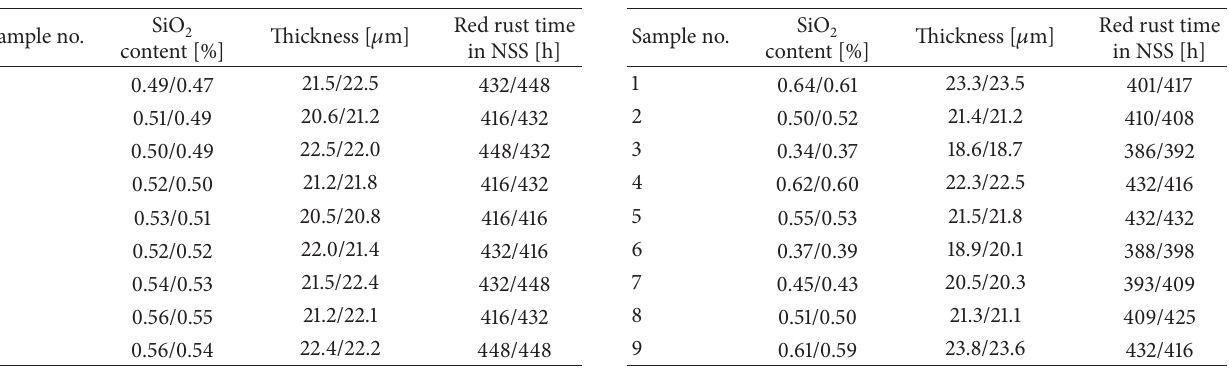
Table 3: SiO content (mass %), thickness, and erosion resistance of 2 composite coatings in different areas of iron plate for V = 1000 r/min and ℎ = 10 mm.